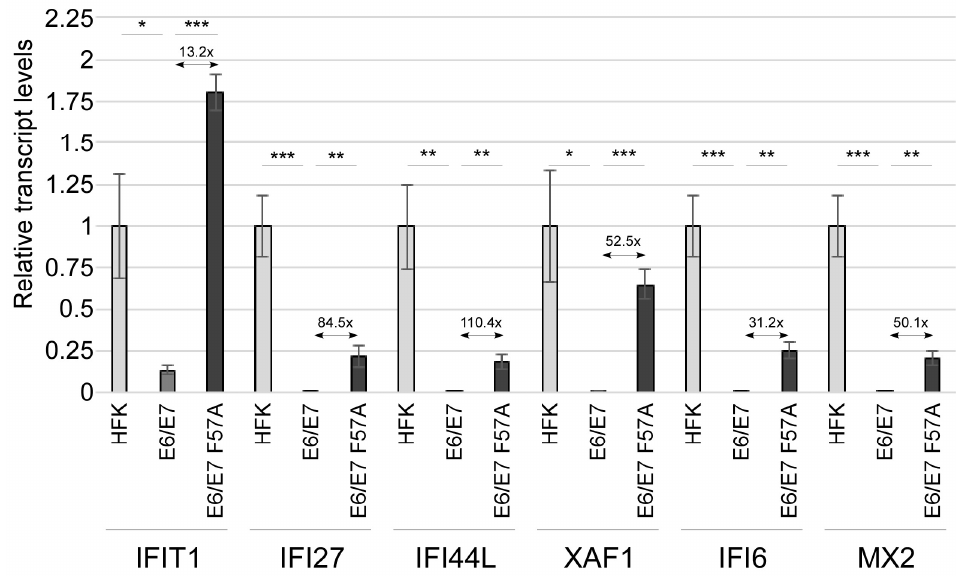
Figure 2. Levels of interferon-stimulated genes (ISG)s. RT-qPCR analysis for ISGs (IFIT1, IFI27, IFI44L, XAF1, IFI6, and MX2) in HFKs, pLXSN E6/E7, and pLXSN E6/E7 F57A cells grown in monolayer